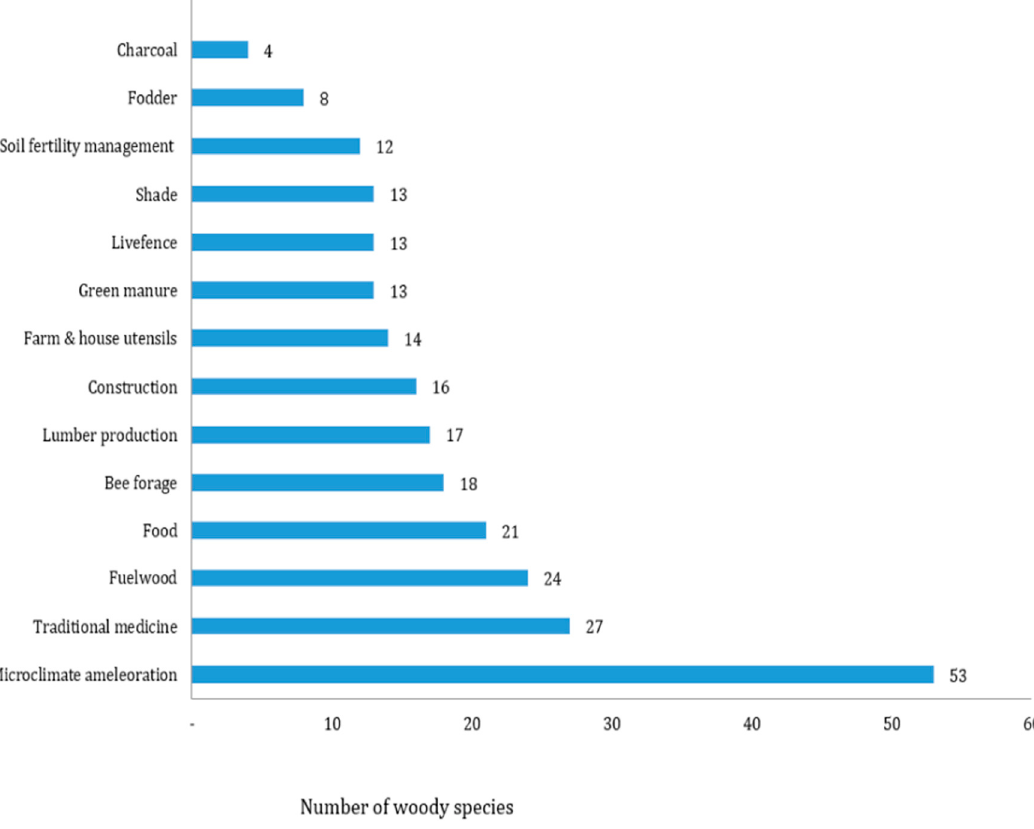
Figure 3. Local uses and values of woody and herbaceous perennial species in home gardens and parkland agroforestry systems in Assosa district, western Ethiopia.